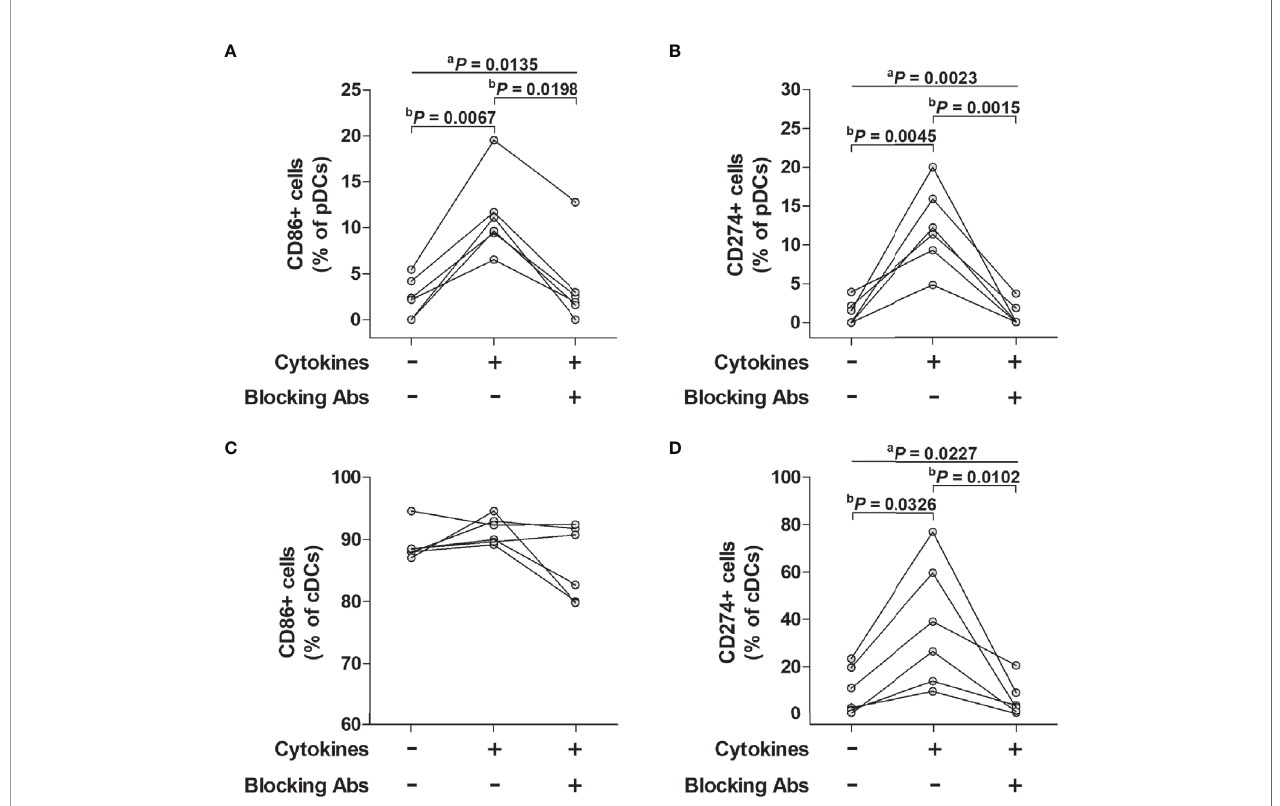
FIGURE 5 | Effect of a pro-in fl ammatory cytokine cocktail and its blocking antibody on surface phenotypes of pDCs and cDCs. Freshly isolated PBMCs were incubated for 24 hours in the presence or absence of cytokine inhibitors (i.e., blocking antibodies against a cocktail of IFN- a , IL-12, and TNF- a and then stimulated with the cytokine cocktail for 16 hours. The stimulated cells were stained with APC-conjugated anti-CD11c, anti-CD86, and anti-CD274; BV421-conjugated anti-HLA-DR; FITC-conjugated Lineage Cocktail 1; PE-conjugated anti-CD86, anti-CD123, and anti-CD274 mAbs and then analyzed by fl ow cytometry. (A, C) Percentage of CD86-expressing pDCs and cDCs. (B, D) Percentage of CD274-expressing pDCs and cDCs. The data were obtained from six HCs. a P values among three groups were calculated by Kruskal-Wallis test. b P values between two groups were calculated by Dunn ’ s post hoc